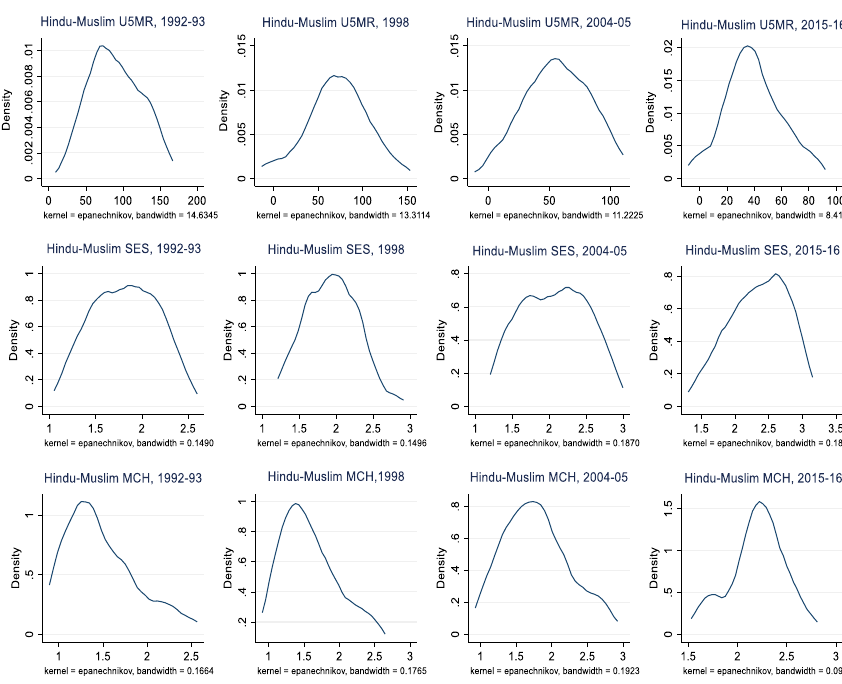
Fig. 5 Non-parametric test of convergence: kernel density plots of showing the distribution of Hindu– Muslim U5MR from 1992–1993 to